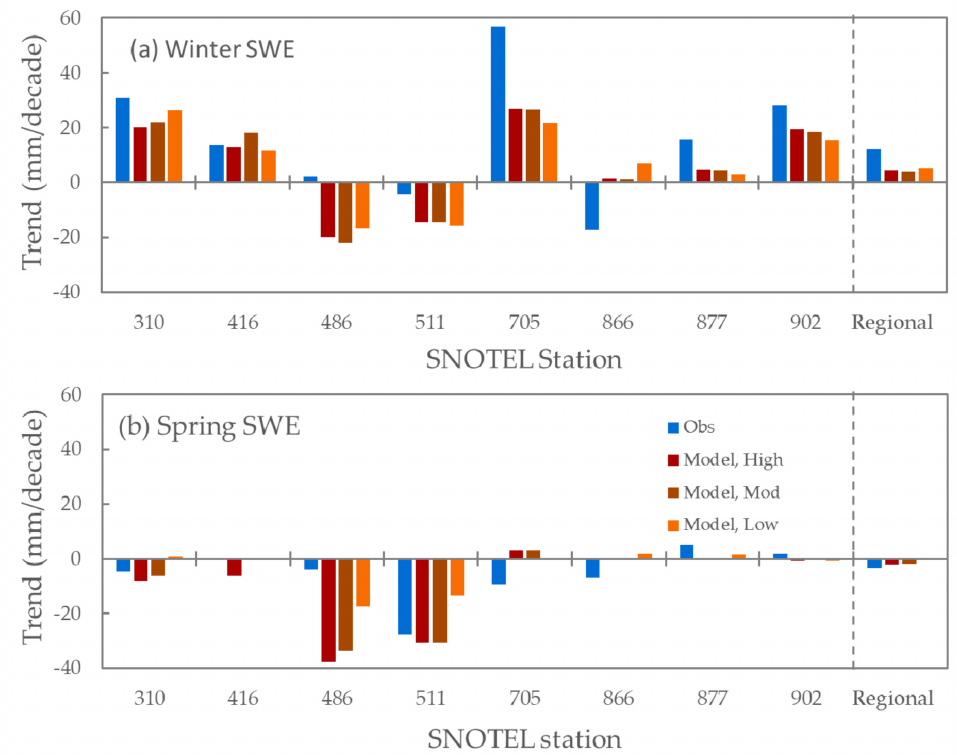
Figure 2. Trends in mean daily observed and simulated SWE in winter (NDJF) ( a ) and spring (MAMJ) ( b ) at SNOTEL stations from 1993–2016. Simulated SWE using forcing data from the Livneh model [34]. Shown are decadal trends calculated with Sen’s slope estimator [45]. Trends at individual stations evaluated using the Mann-Kendall test [42,43] and trends across all stations evaluated using the regional Mann-Kendall test (right panel) [44]. None of the trends were significant at p <